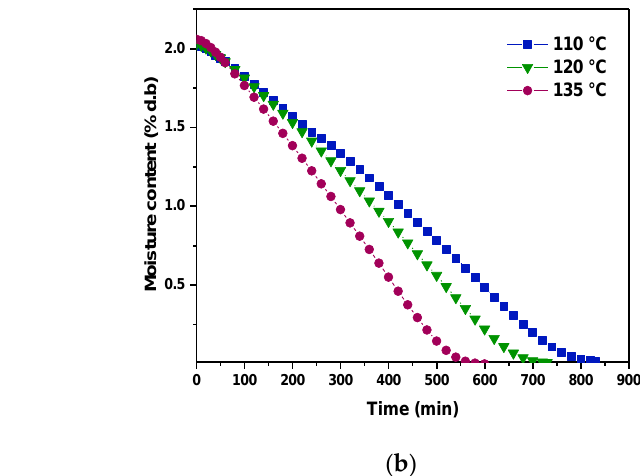
Figure 4. Variation of the drying rate versus the moisture content, ( a ): 1 cm and ( b ): 2 cm.